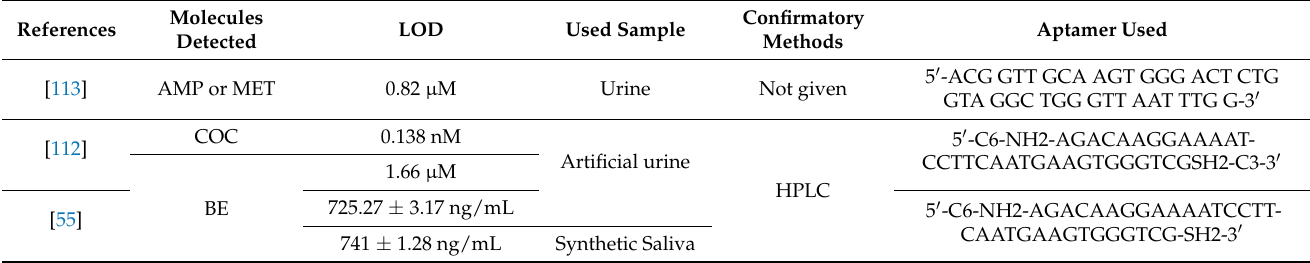
Table 3. Some nucleic acids LFA methods for the determination of DOA in biological samples that have been reported in the